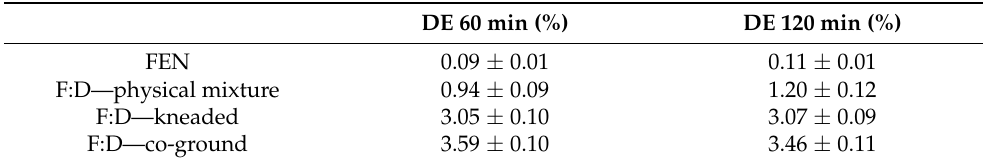
Table 1. Calculated dissolution efficiency values at 60 and 120 min of FEN, and increased values of FEN:DIMEB (F:D) products.